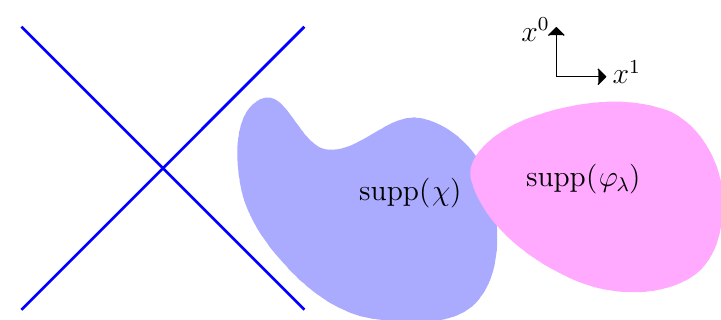
Figure 5 . Location of supports of ϕ λ and χ with respect to the singularity light cone of f